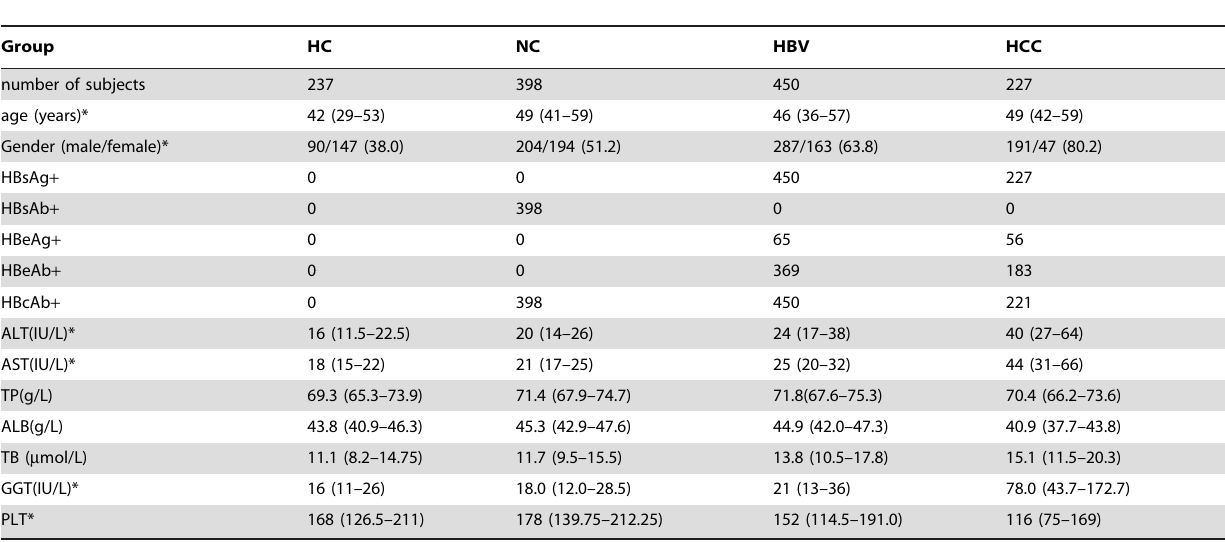
Table 1. Clinical characteristics of subjects recruited in this